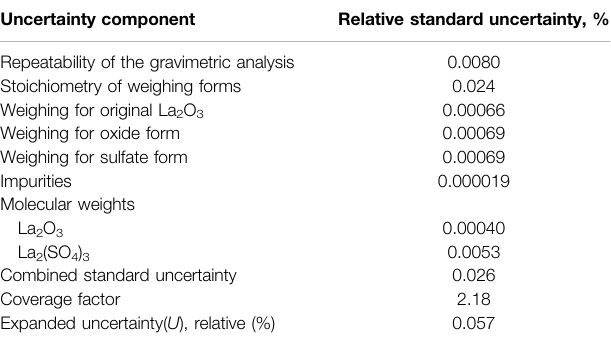
TABLE 7 | Contribution of measurement uncertainty in the purity analysis of the original La 2 O 3